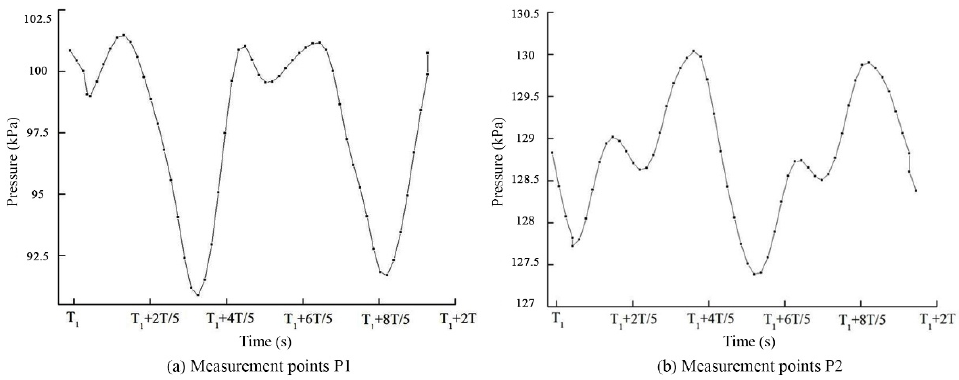
Figure 10. Pressure time domain diagram of P1 and P2 at 6278 rpm. ( a ) P1; ( b ) P2.